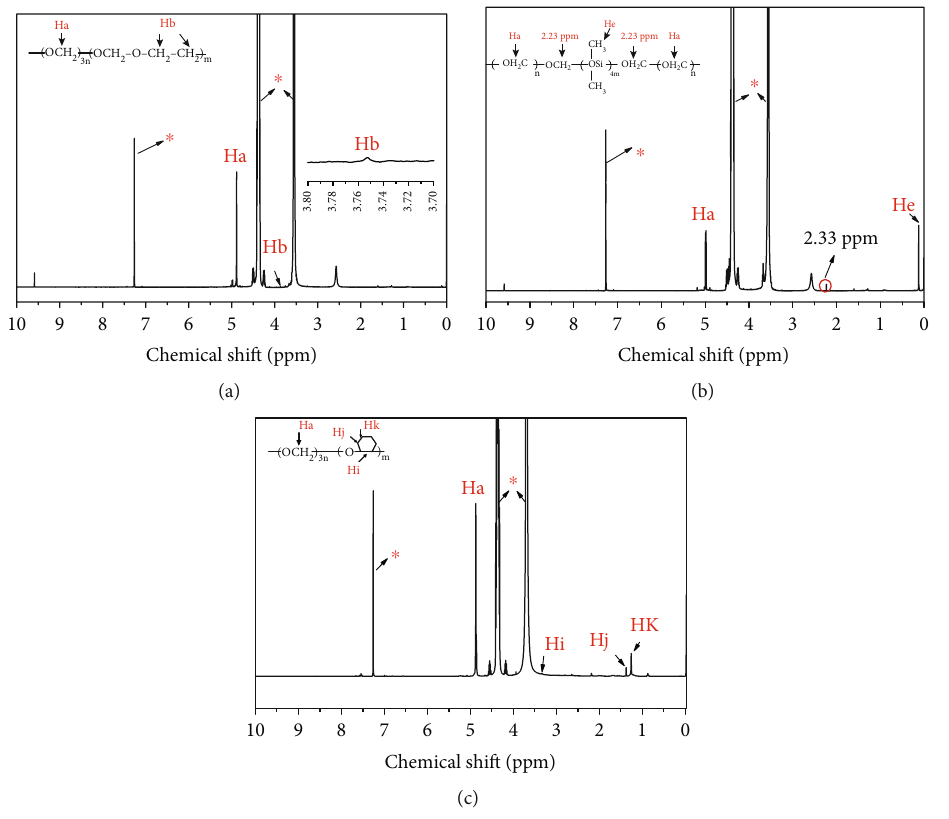
Figure 2: 1 H-NMR spectra of the copolymer. (a) The copolymer of TOX with DOX. (b) The copolymer of TOX with D4. (c) The copolymer of TOX with CHO. Signal ∗ represents 1,1,1,3,3,3-hexa fl uoro-2-propanol and deuterated chloroform